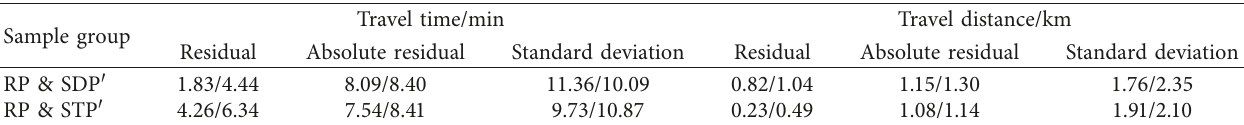
Table 12: The deviation between the actual and the shortest paths of the fixed/nonfixed OD trips on the weekend. Travel time/min Travel distance/km Sample group